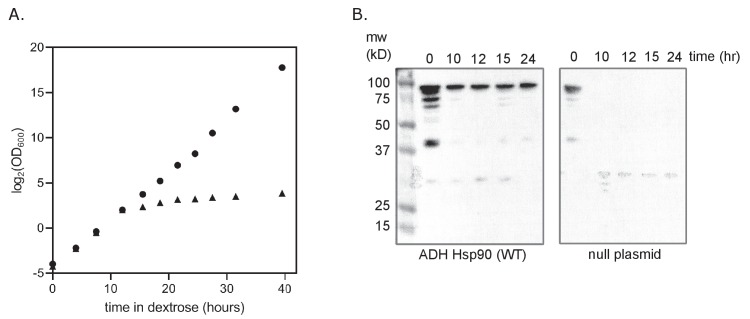
Validation of yeast Hsp90-shutoff strain.(A) Growth of Hsp90 shutoff yeast harboring either wild-type (WT) Hsp90 under the ADH promoter (●) or a null plasmid (▲). Growth was monitored by optical density (OD) at 600 nm. (B) Hsp90 expression in cells harboring the same plasmids grown in dextose for the stated number of hours. Hsp90 protein levels were monitored by western blotting.